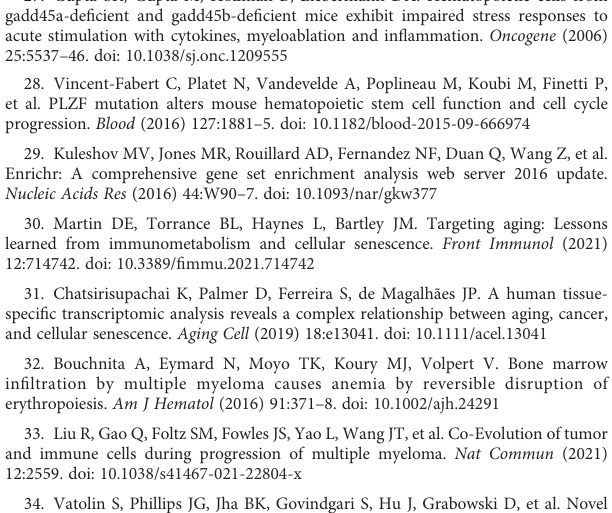
SUPPLEMENTARY TABLE 6 Age predictions of diseased samples.